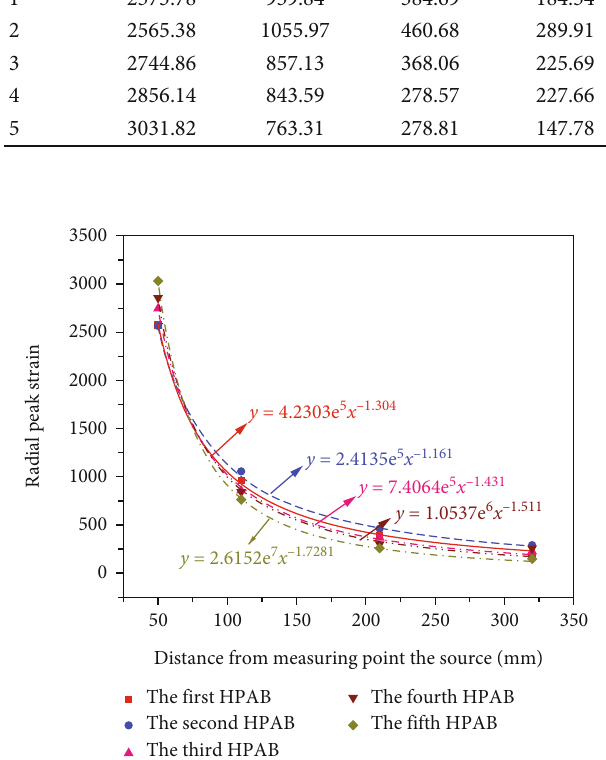
Figure 5: The fi tting curve between the strain peak and the distance.